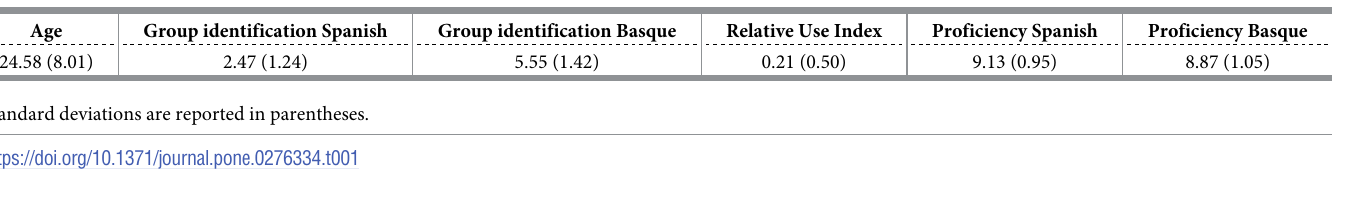
Reaction time (RT) analysis. Linear-mixed effects regressions were performed on the reaction times using the lme4 package [48]. In the mixed model, the factor Response Type (correct, error) was introduced as fixed effect, and Participant and Item as random effects. As the data were not normally distributed, we used the Box-Cox test [49], using the function box- cox in the package “MASS” [50] to estimate the most appropriate transformation for the data to reduce skewedness and approximate a normal distribution. Participants were faster select- ing the correct response compared to when an incorrect choice was performed (SE = .38, t = 2.88, p = .004, See Fig 3A). In a second level of analysis we tested whether there was a differ- ence between RTs to same-language and different-language incorrect choices. No significant differences emerged (SE = .35, t = .54, p = .59, See Fig 3B).